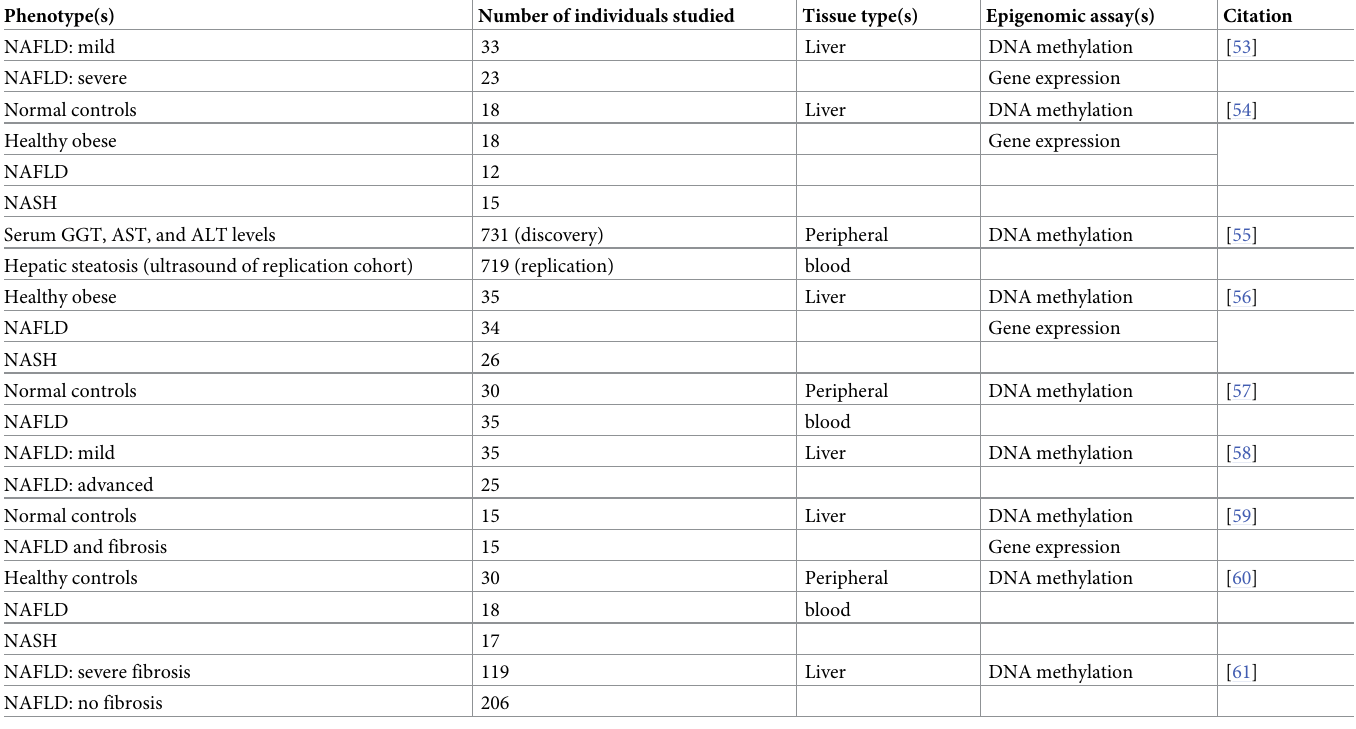
Table 2. Examples of prior EWAS performed in NAFLD and